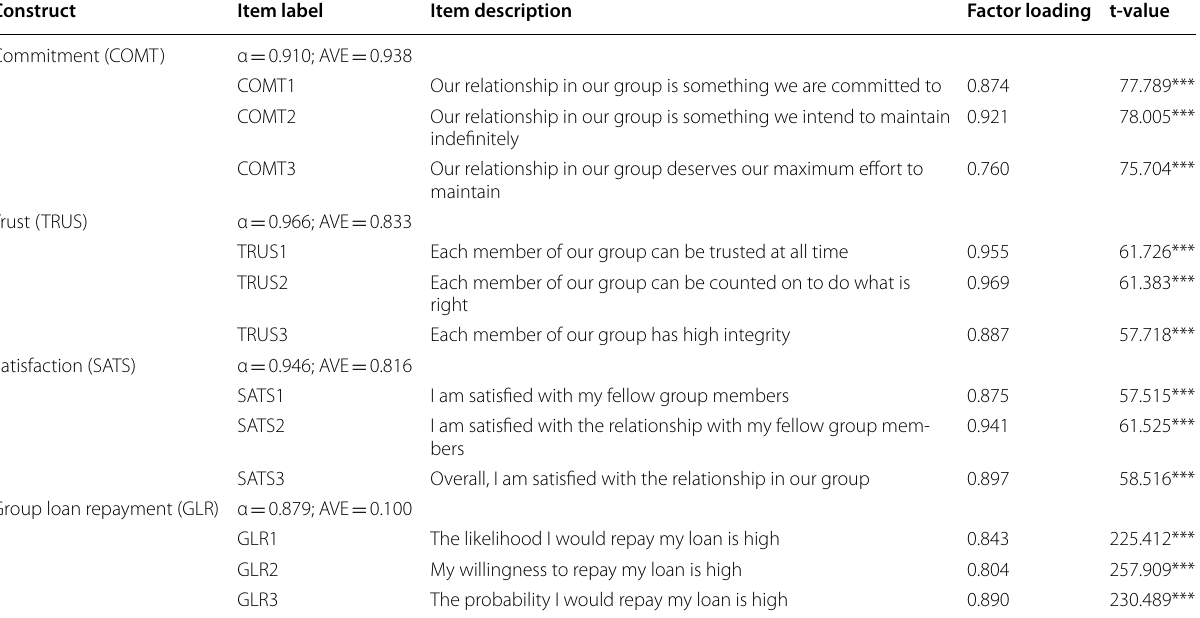
KMO and Bartlett’s test of sphericity